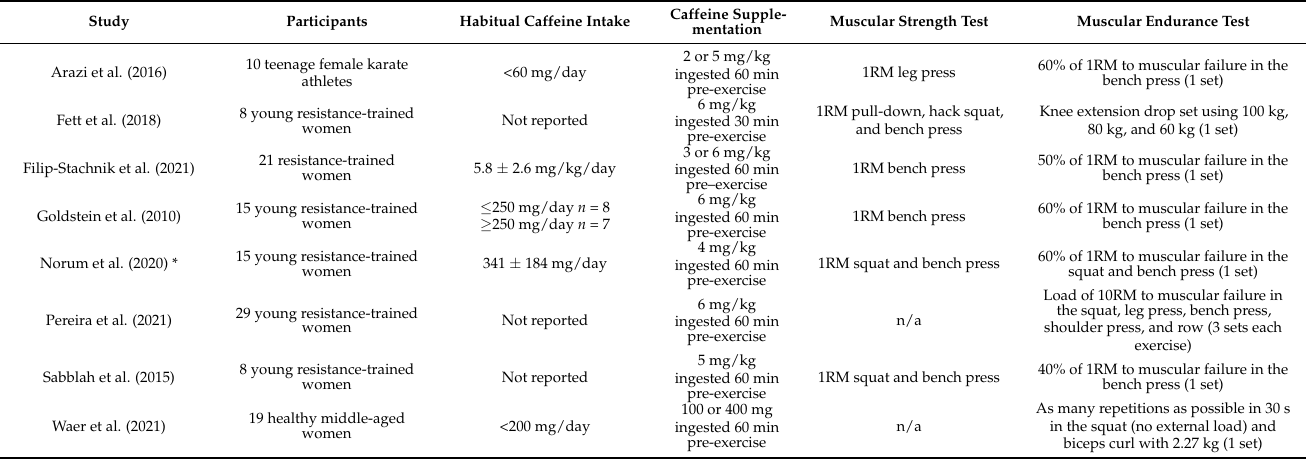
Table 1. Summary of studies included in the review.